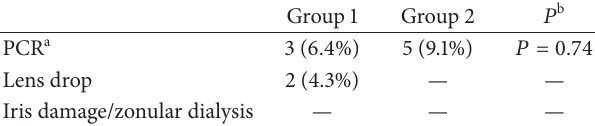
Table 3: Incidence of complications during cataract